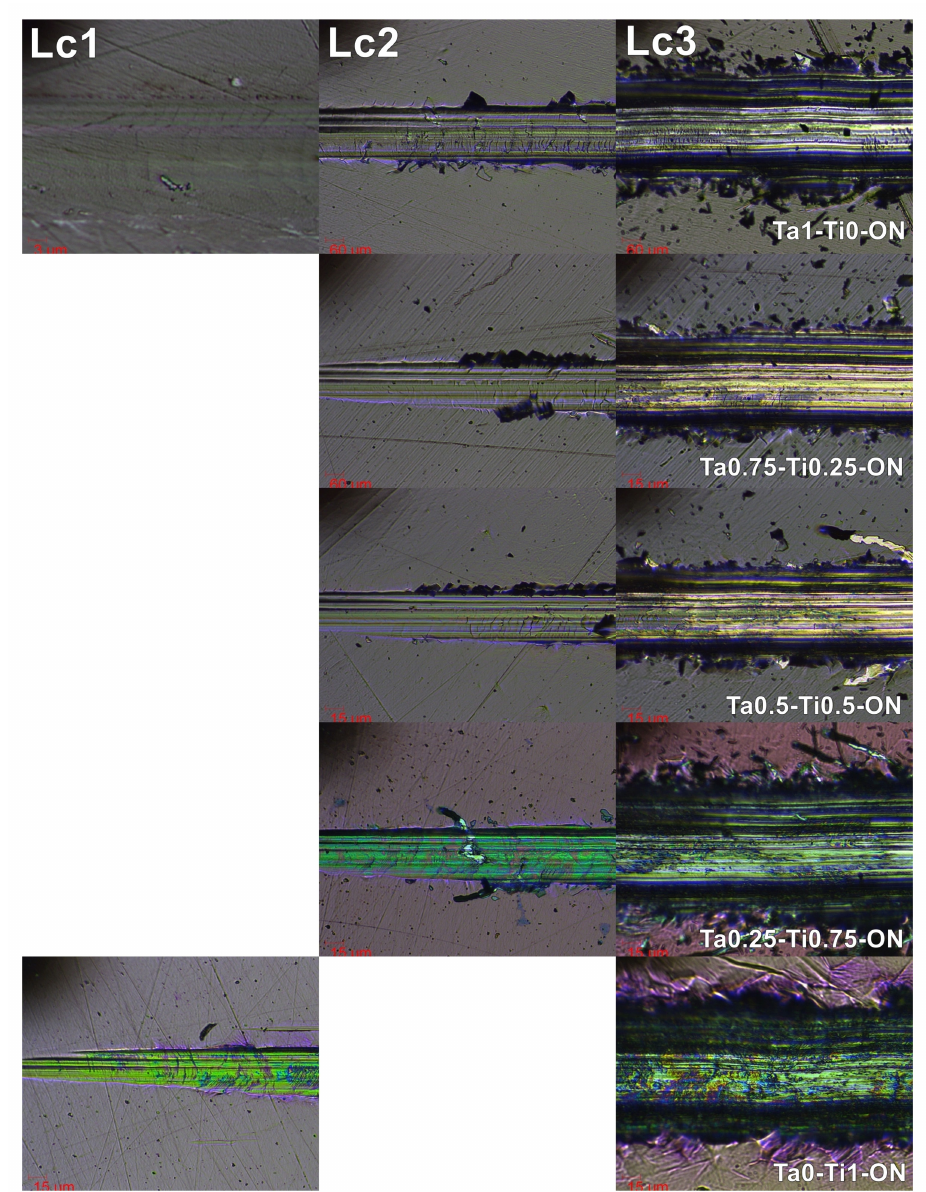
Figure 8. Representative micrographs of coating failure: Lc 1—first cracks; Lc 2—first delamination; Lc 3—total film